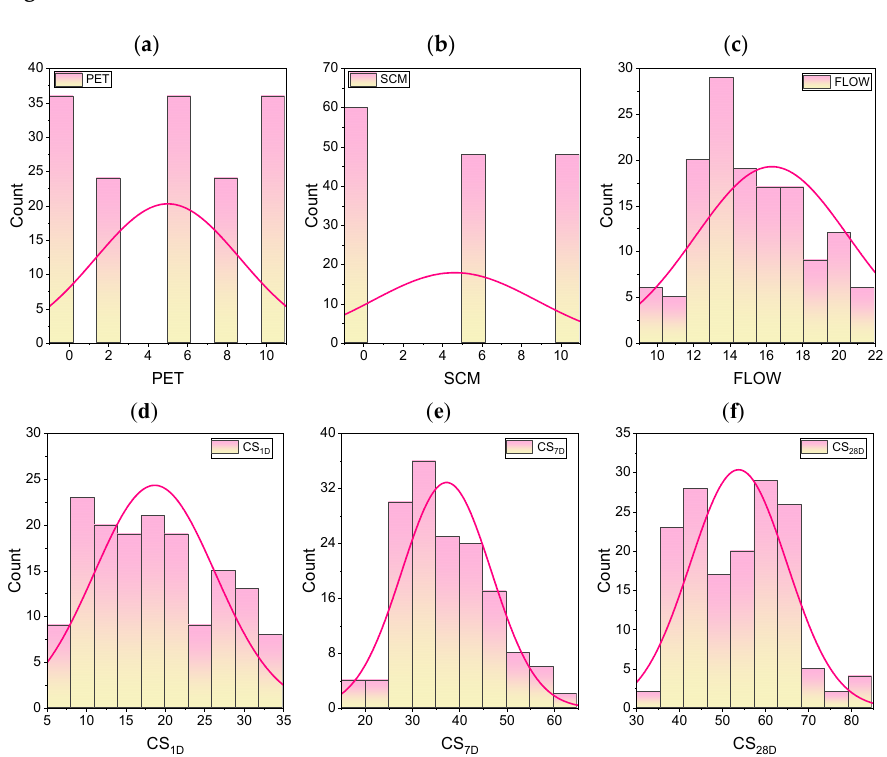
Figure 2. Correlation matrix.